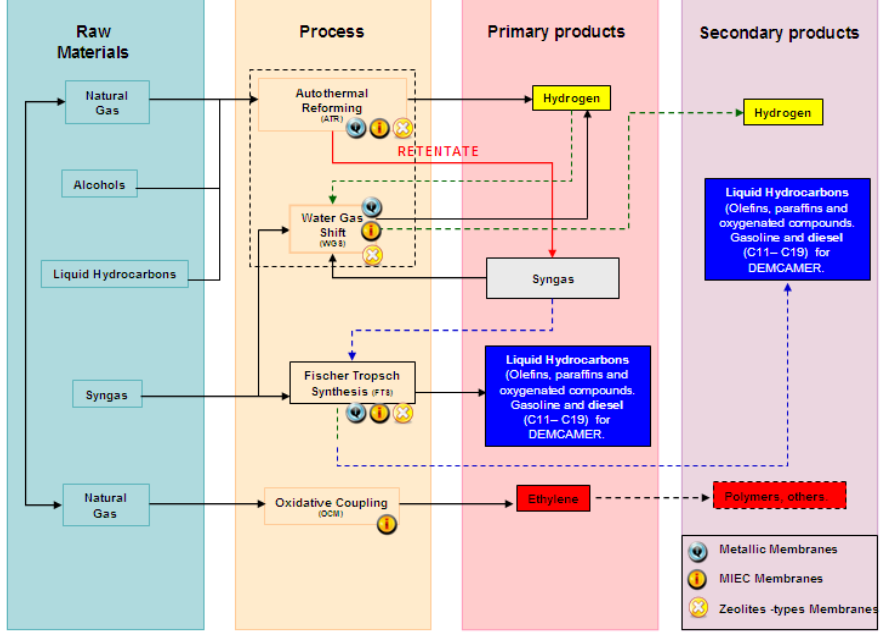
Figure 2. Flow sheet of the four chemical processes addressed in DEMCAMER. Table 1. Raw materials and obtained products per each targeted reaction.